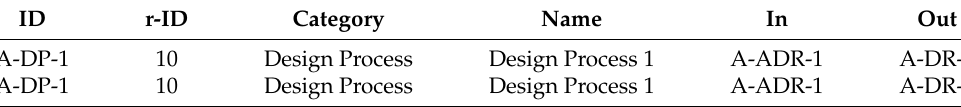
Table A3. Annotated Design Process for the bike crank use